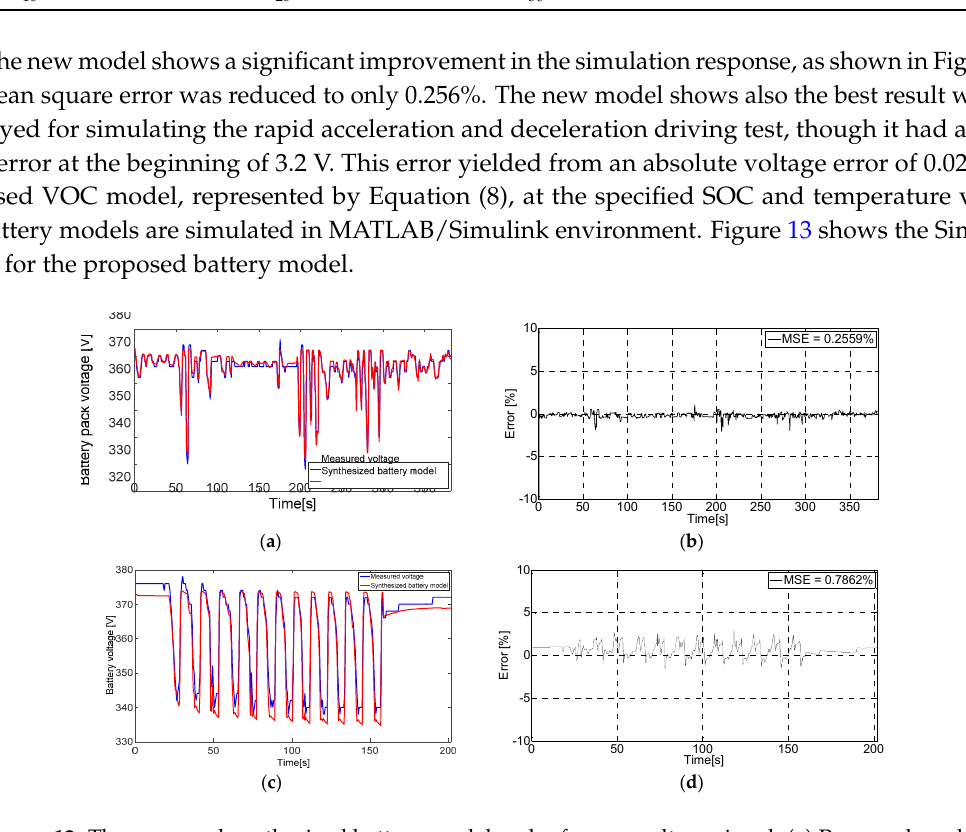
Table 5. Constants values of Equations (14)–(18).